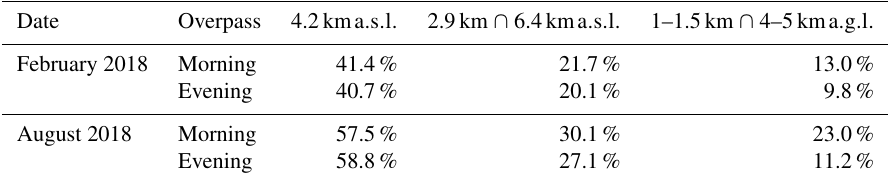
Figure 7. Monthly averages for February and August 2018 for the DOFS of the {H 2 O, δ D} pair product without {H 2 O, δ D} pair quality filtering, evaluated on a 1 ◦ × 1 ◦ grid. Table 2. Averaged fractions of available MUSICA IASI {H 2 O, δ D} pair data after applying the quality filter according to Table 1, compared to the full (i.e. unfiltered) cloud-free IASI observations. The results are shown for 4.2kma . s . l . (above sea level), for observations where the filter conditions are fulfilled simultaneously at 2.9 and 6.4kma . s . l . and at 1–1.5 and 4–5kma . g . l . (above ground level), respectively. For the latter, if more than one grid level falls inside the given altitude range, then the lower one is chosen.